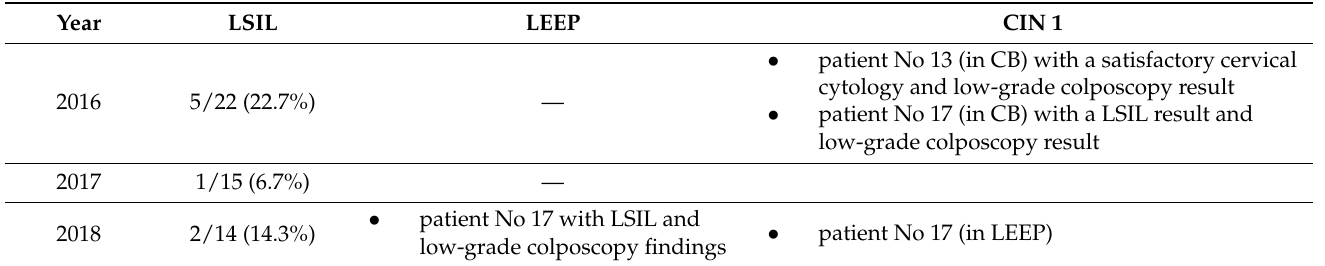
Scheme 1. Results of the six-year follow-up gynecological examinations. hrHPV: high-risk human papillomavirus; LSIL: low-grade squamous intraepithelial lesion; ASCUS: atypical squamous cells of undetermined significance; CIN 1: cervical squamous intraepithelial neoplasia 1; VAIN 1: vaginal intraepithelial neoplasia 1; LEEP: loop electrosurgical excision procedure. * The result of a biopsy obtained in a different department, as reported by the patient. Table 2. Abnormal cervical cytology and histopathological results during the